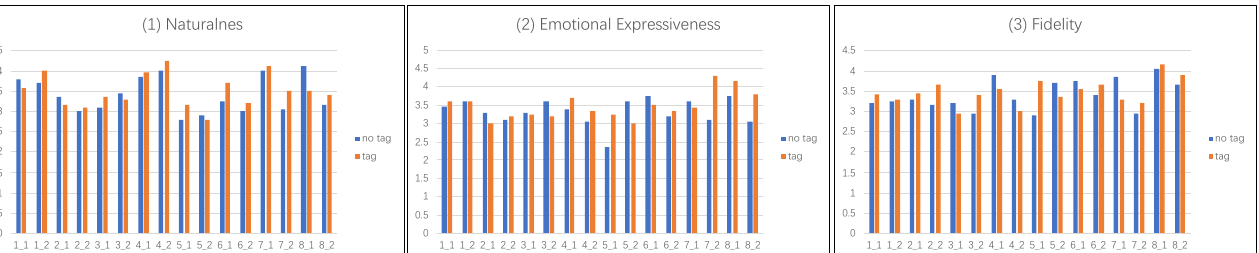
Figure 10. The second user study. Each participant was asked to answer questions in three indicators: naturalness, emotional expressiveness, and fidelity.